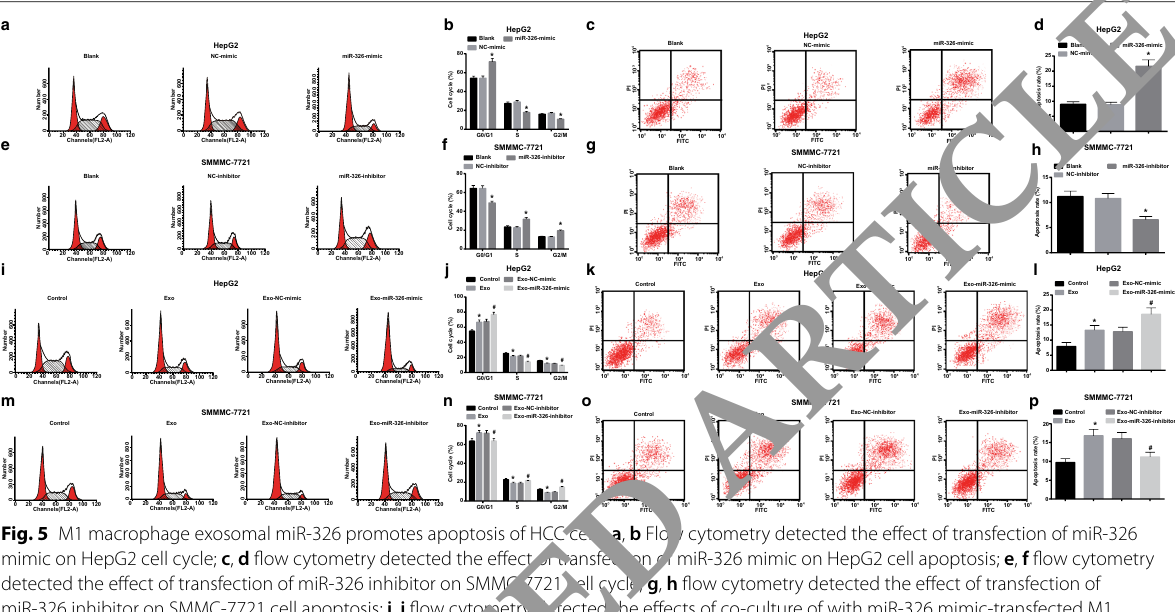
Fig. 5 M1 macrophage exosomal miR‑326 promotes apoptosis of HCC cells. a , b Flow cytometry detected the effect of transfection of miR‑326 mimic on HepG2 cell cycle; c , d flow cytometry detected the effect of transfection of miR‑326 mimic on HepG2 cell apoptosis; e , f flow cytometry detected the effect of transfection of miR‑326 inhibitor on SMMC‑7721 cell cycle; g , h flow cytometry detected the effect of transfection of miR‑326 inhibitor on SMMC‑7721 cell apoptosis; i , j flow cytometry detected the effects of co‑culture of with miR‑326 mimic‑transfected M1 macrophage‑derived exosomes on HepG2 cell cycle; k , l flow cytometry detected the effect of co‑culture with miR‑326 mimic‑transfected M1 macrophage‑derived exosomes on HepG2 cell apoptosis; m , n flow cytometry detected the effect of co‑culture with miR‑326 inhibitor‑transfected M1 macrophage‑derived exosomes on SMMC‑7721 cell cycle; o , p , flow cytometry detected the effect of co‑culture with miR‑326 inhibitor‑transfected M1 macrophage‑derived exosomes on SMMC‑7721 cell apoptosis. In panel b and d, * P < 0.05 versus the NC‑mimic group; In panel f and h, * P < 0.05 versus the NC‑inhibitor group; In panel j and l, * P < 0.05 versus the control group, # P < 0.05 versus the Exo‑NC‑mimic group; In panel n and p, * P < 0.05 versus the controlgroup, # P < 0.05 versus the Exo‑NC‑inhibitor group. Measurement data were depicted as mean standard deviation ( N 3), comparisons among multiple groups were conducted by one‑way analysis of ± =